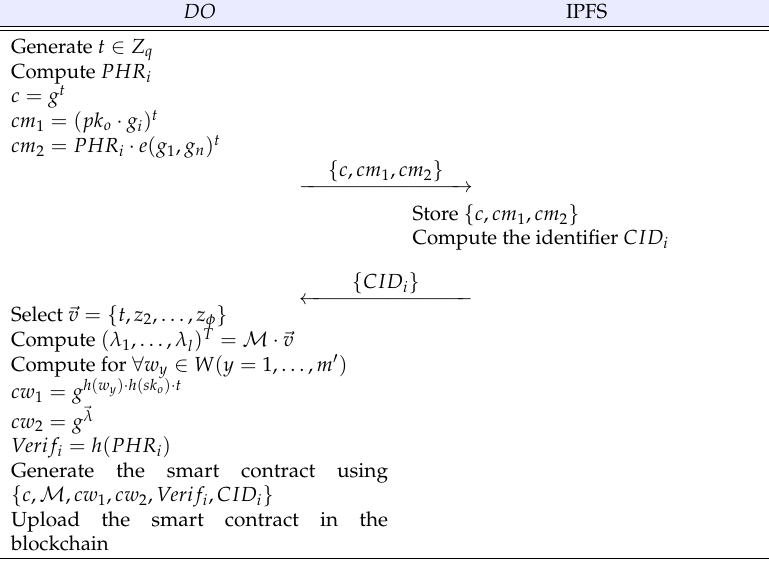
Figure 2. Data upload